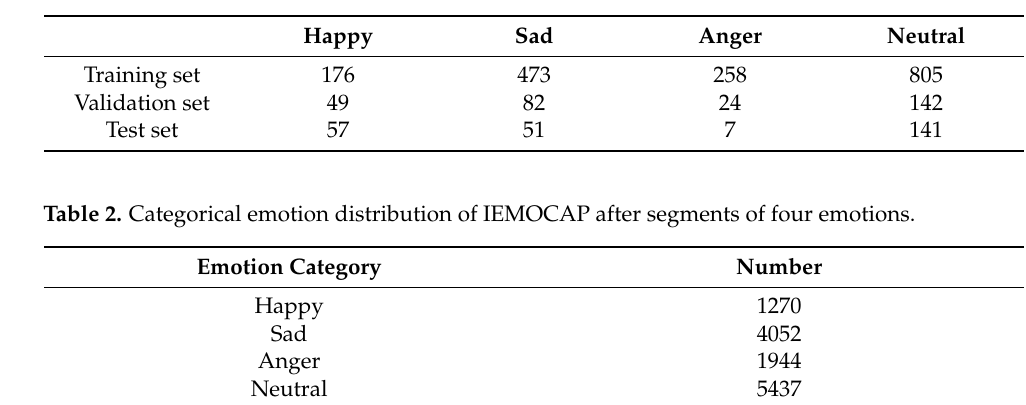
Table 1. Categorical emotion distribution of IEMOCAP with four emotions in training, validation, and test set.